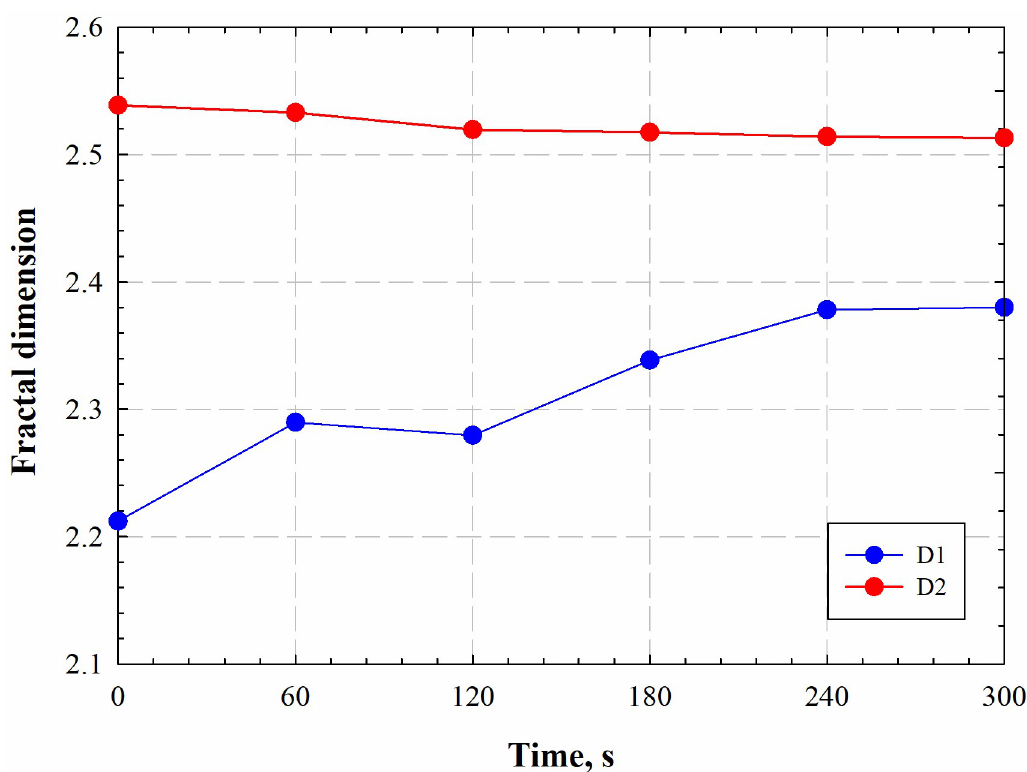
Fig 12. Variations in the fractal dimension of D 1 and D 2 for marine shale samples at different electromagnetic radiation time.